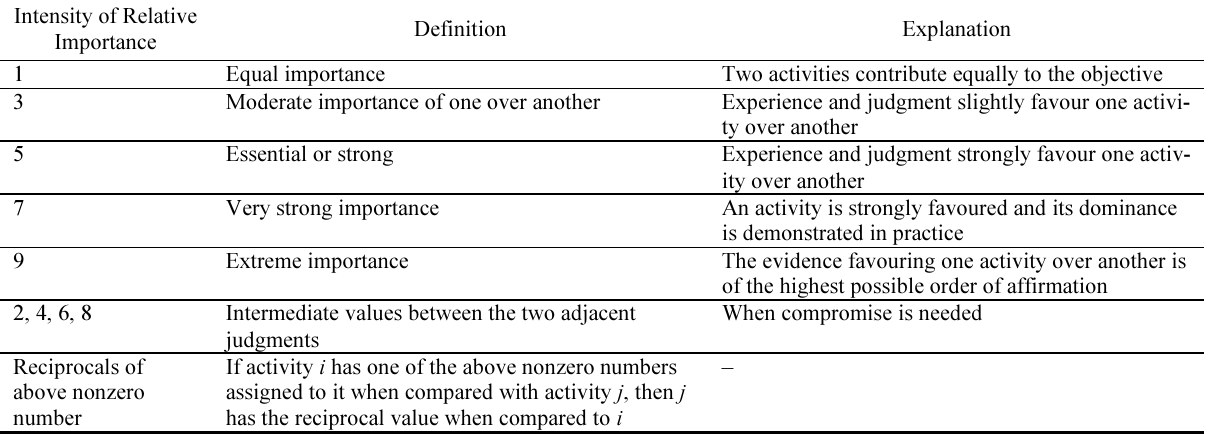
Table 4. Scale of relative importance (Saaty 1990)